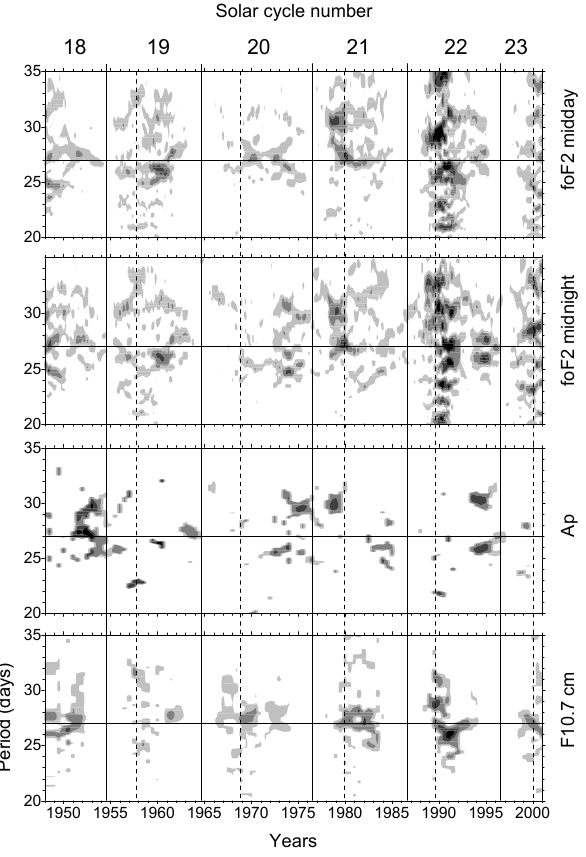
Fig. 1. Dynamic amplitude spectra in the period range from 20 to 35 days of solar radio flux F10.7 cm, geomagnetic activity index A p and critical frequencies fo F2 for midday and midnight (Moscow) over the years 1947–2001. Solar cycle maxima and minima are marked with dashed and thin vertical lines, respectively. Highest amplitudes are painted in a black tone. The 27-day period is indi- cated by a horizontal line in each